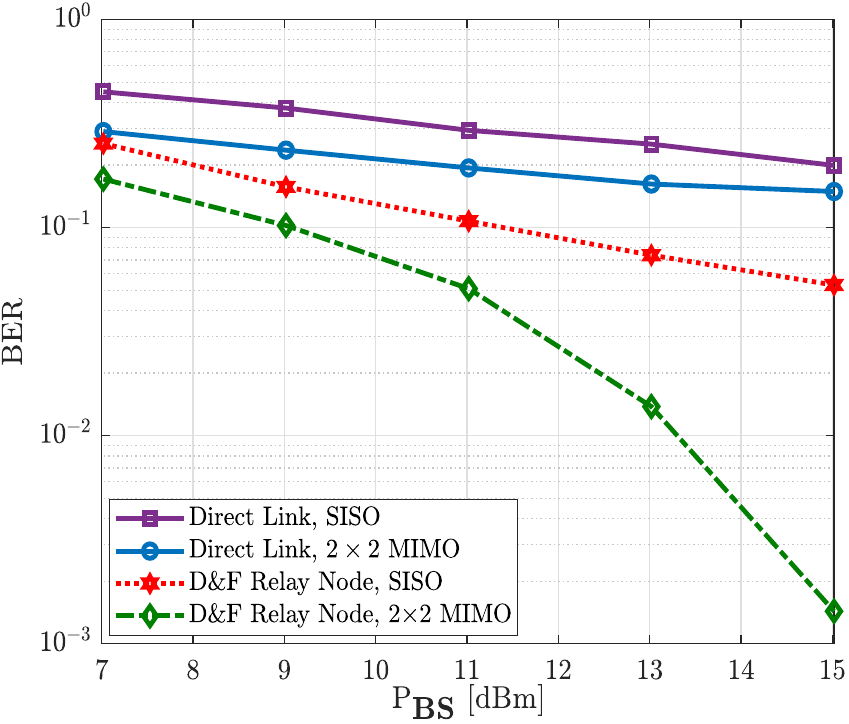
Figure 18. BER vs. P BS of the relay node co-operative 5G network;